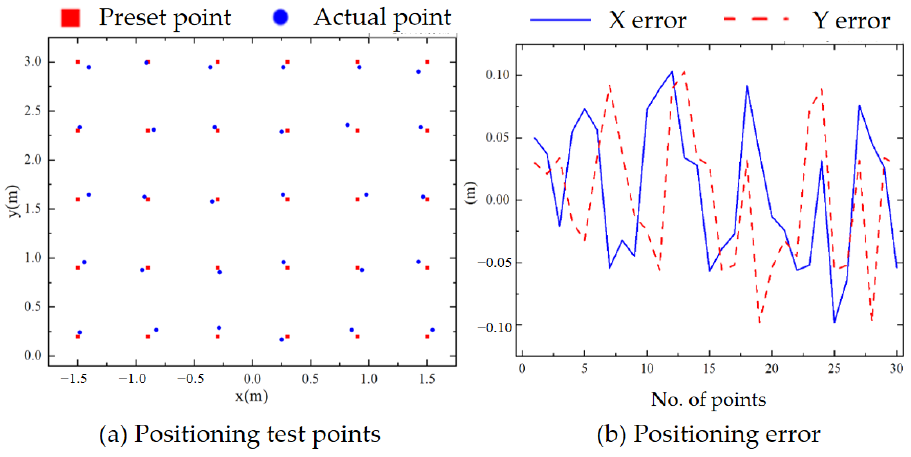
Figure 16. Positioning test results analysis.